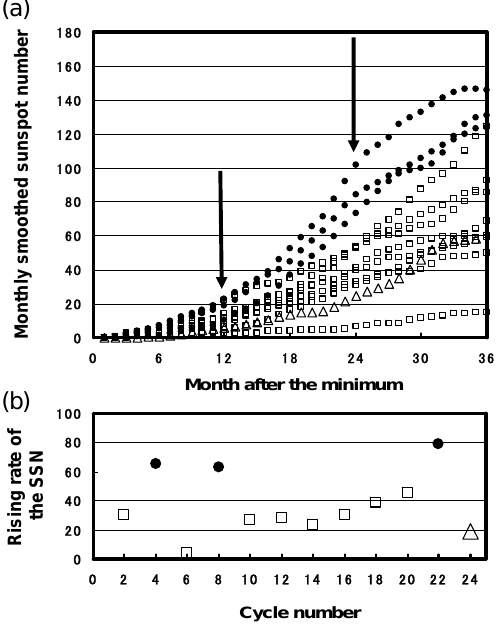
Figure 6. (a) Increase of the SSN of even-numbered cycles in 36 months after taking minimum values. Curves plotted by solid points show cycles 4, 8, and 22 for which succeeding odd-numbered cy- cles became outliers. Minimum values are set to be 0 for all cycles. (b) Increasing rate of the SSN during the period 12–24 months after minima. Note that the increasing rate for cycles 4, 8, and 22 were exceptionally large. A triangle represents the increasing rate of the current cycle 24. Its small increasing rate suggests that cycle 25 will not be an